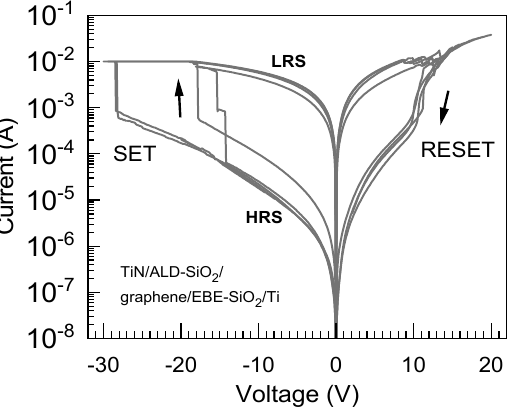
Figure 8. Resistively switching current–voltage curves measured from the TiN/SiO 2 /graphene/(EBE)SiO 2 /Ti devices (Sample 5 in Table 1).